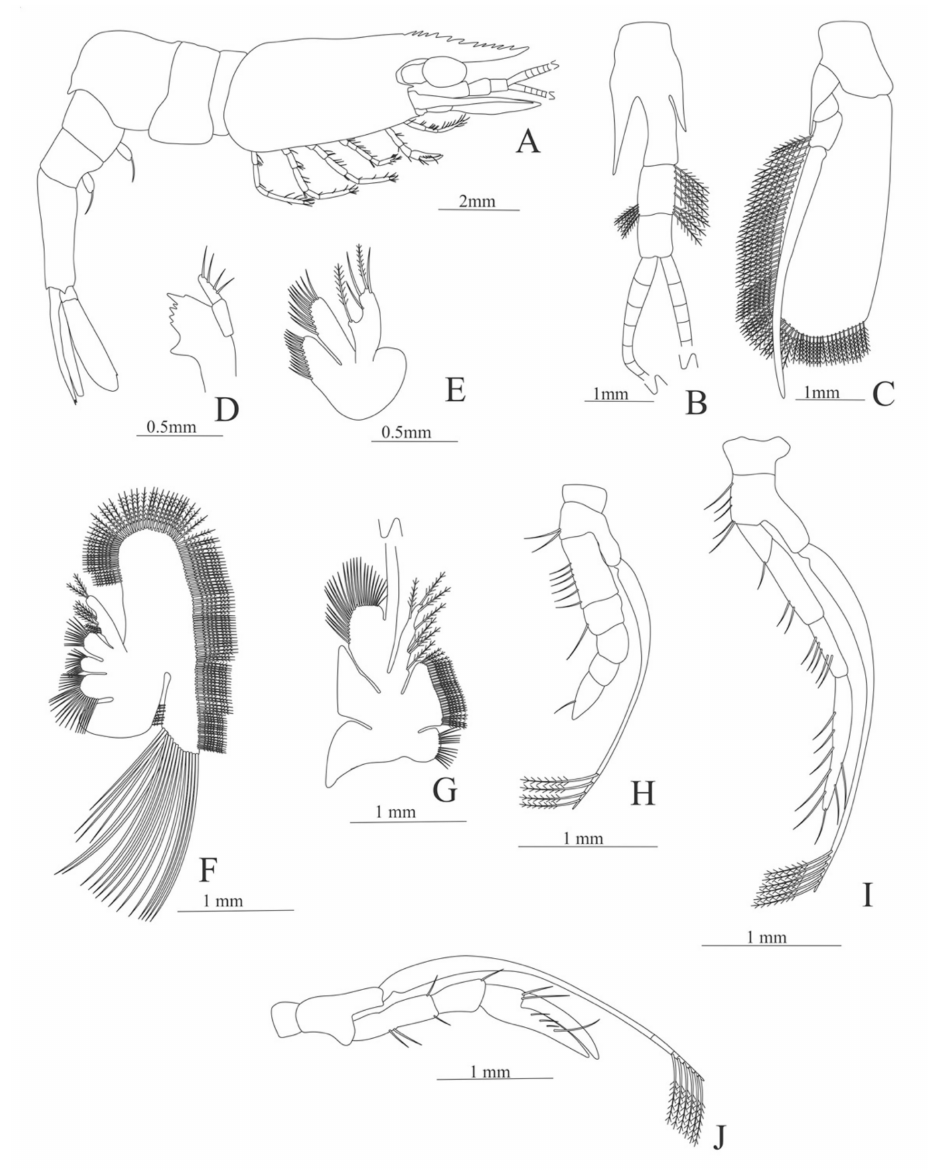
Figure 8. Alvinocaris stactophila : ( A ) lateral view; ( B ) antennule; ( C ) antenna; ( D ) mandible; ( E ) maxillule; ( F ) maxilla; ( G ) first maxilliped; ( H ) second maxilliped; ( I ) third maxilliped; ( J ) first